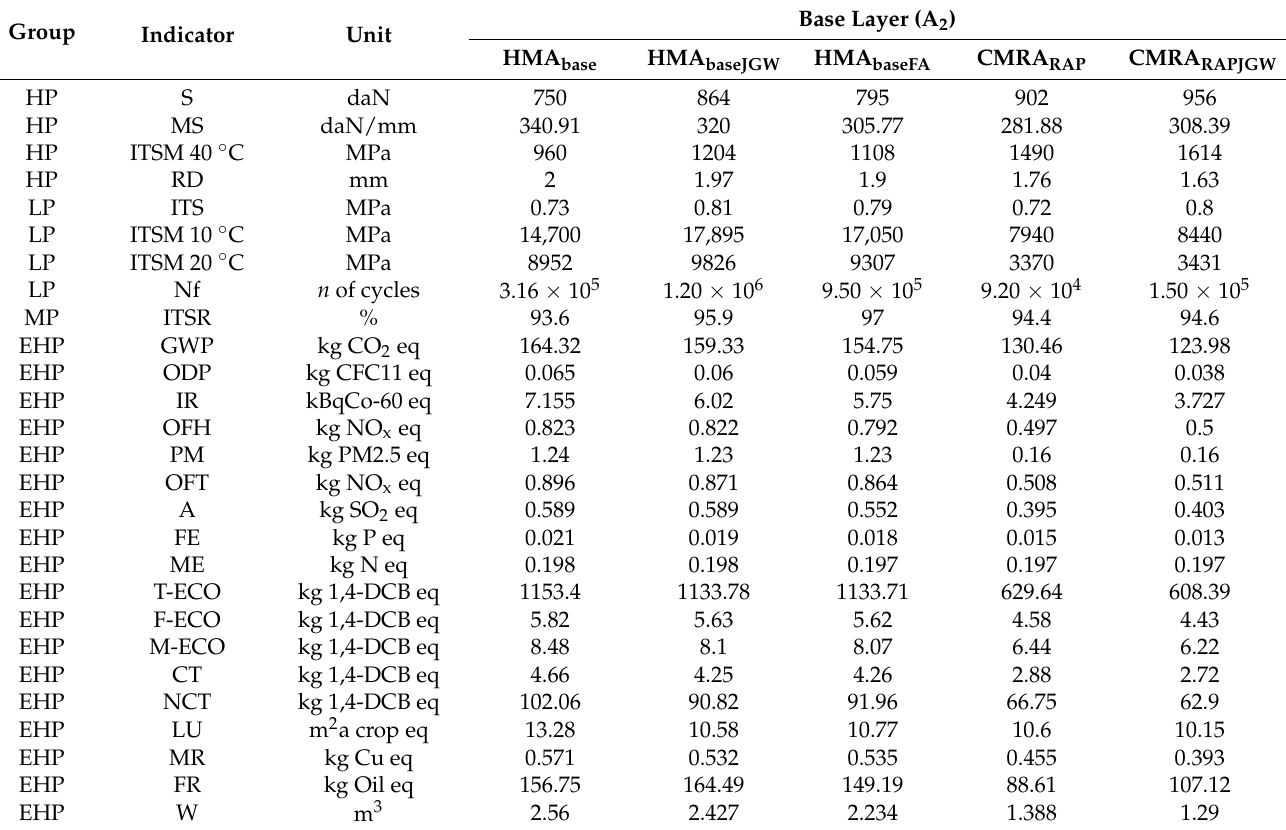
Table 4. Mechanical characteristics and LCA parameters reported as the decision matrix A 2 for base layer adopted for